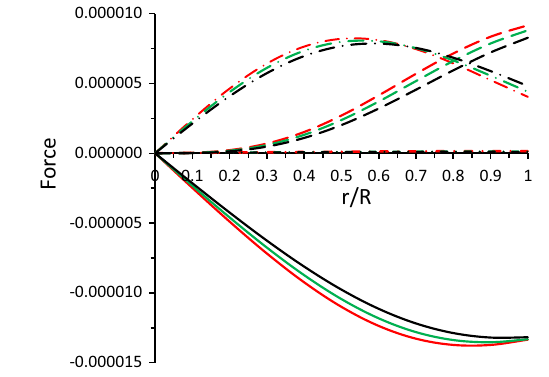
Fig. 4 The behavior of different forces: F g (solid lines), F h (long dashed-dot), F e (long dashed), and F a (small dashed-dot) verses radial coordinate r / R . The description of the figure is as follows: (i) red color curves corresponding to the star PSR J1614-2230 for α = 0 . 001; (ii) green color curves corresponding to the star 4U1608-52 for α = 0 . 0012 and (iii) green color curves corresponding to the star Cen X-3 for α = 0 . 0014.Thenumericalvaluesoffreeparametersare: a = 0 . 00509, b = 0 . 00002, β = 1 . 8 and γ = 0 . 0001.